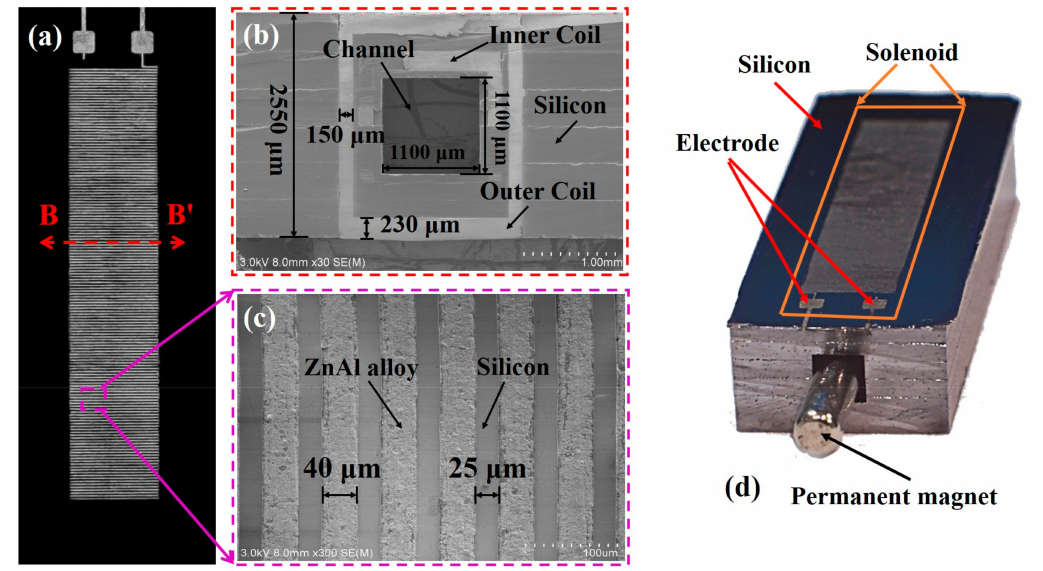
Figure 5. Fabricated double-deck 3D metal solenoid. ( a ) Top view scanning electron microscope (SEM) image of the solenoid. ( b ) Cross- sectional view of the solenoids that is cut along the line B-B’ in ( a ); ( c ) enlarged top view showing the ZnAl-alloy wires; ( d )